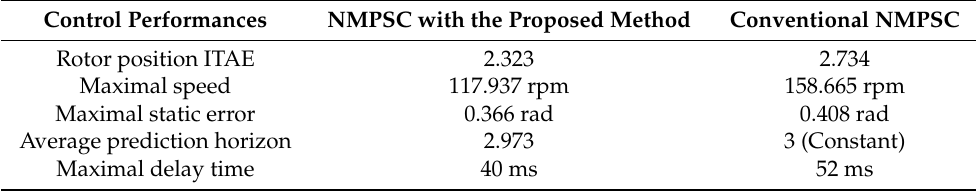
Table 5. Performance comparison in three cycles. Control